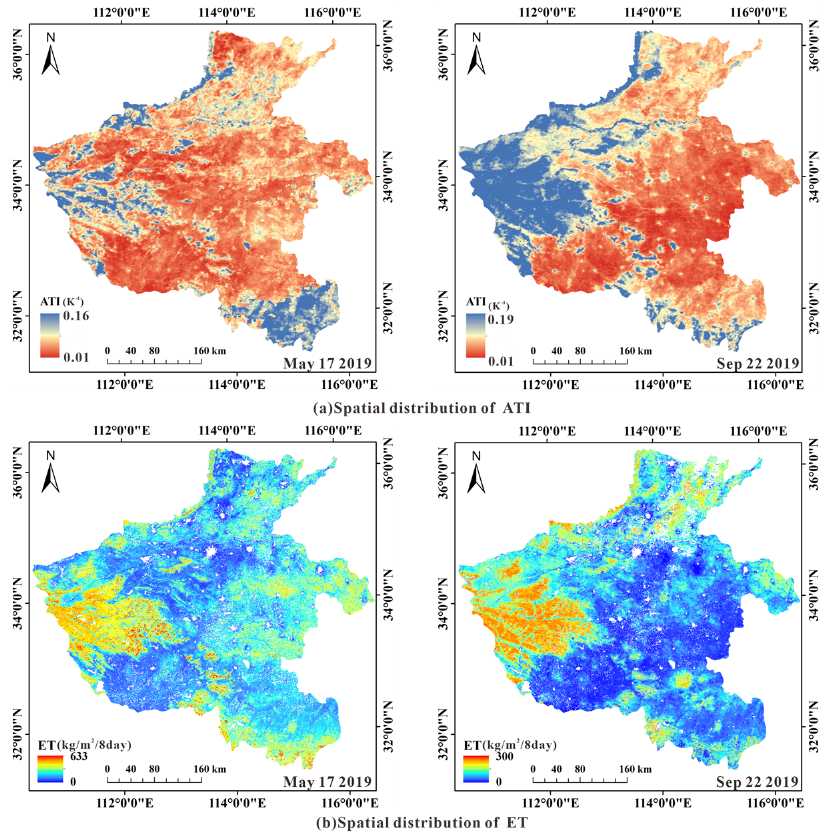
Figure 6. Spatial distribution of ATI and ET.